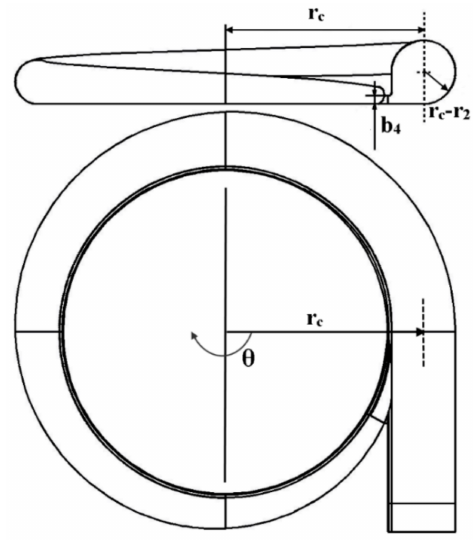
Figure 5. An external circular volute